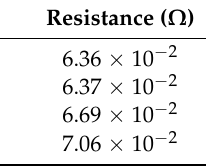
Figure 3. Electron probe microanalyzer (EMPA) images of the interfacial regions for ( a ) the EP and ( b ) the HD PV modules. Table 2. Series resistance of metal Al, Cu ∙ Zn/Al, Sn/Cu ∙ Zn/Al (EP) and Sn/Cu ∙ Zn/Al (HD) ribbons.